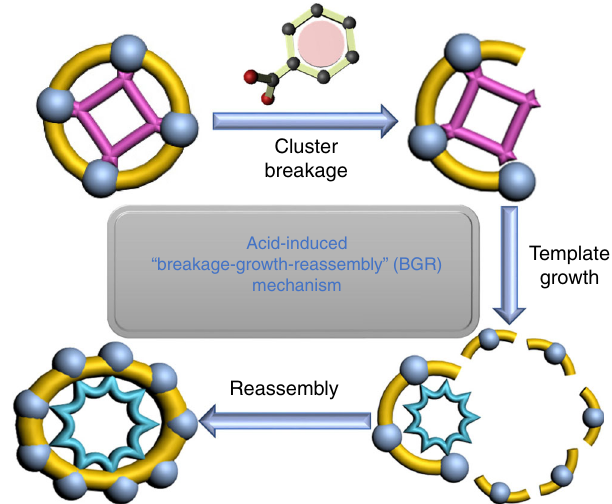
Fig. 6 The proposed breakage-growth-reassembly mechanism for the transformation process from SD/Ag44 to SD/Ag50